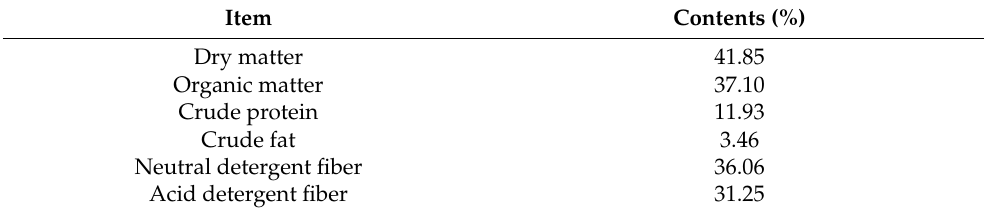
Table 2. Nutrient composition (dry matter basis) of A. sinensis